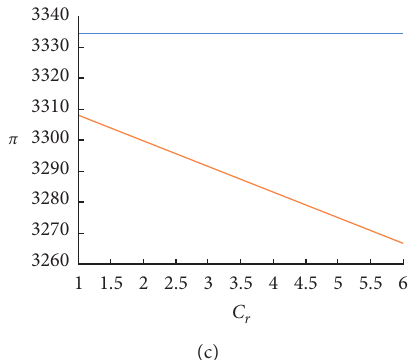
Figure 4: The relationship between the lead time t